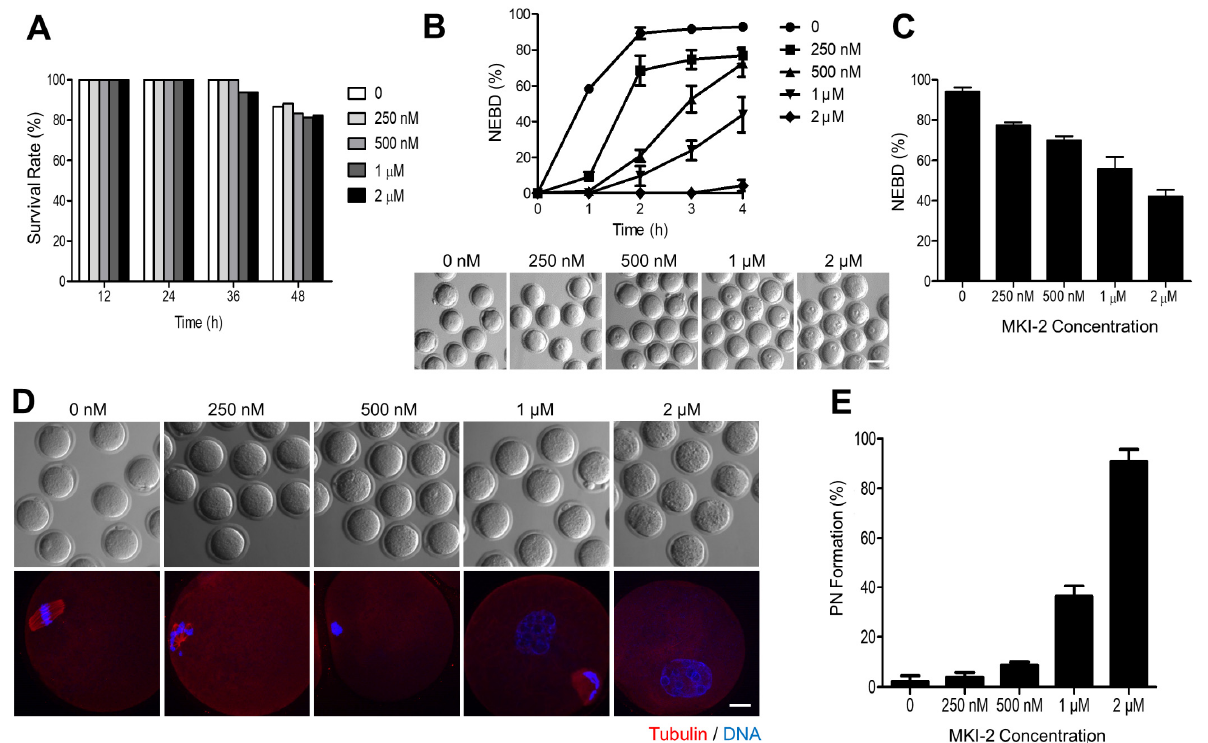
Figure 5. Validation of MKI-2 activity using mouse oocytes ( A ) GV oocytes were treated with 0, 0.25, 0.5, 1.0, and 2.0 µ M MKI-2 and scored for survival rate up to 48 h. ( B ) After 30 min of culture with MKI-2 and IBMX, GV oocytes were released from prophase arrest by washing out IBMX and were scored for GVBD. The percentage of GVBD was expressed as mean ± SEM from three independent experiments. Representative images at 4 h of culture following IBMX release were shown. Scale bar, 100 µ m. ( C ) After 18 h of culture with MKI-2 in the absence of without IBMX, the percentage of GVBD was scored and expressed as mean ± SEM from three independent experiments. ( D ) MII oocytes were collected and treated with MKI-2 in M2 medium for 8 h. Oocytes were fixed and stained with anti-tubulin antibodies. DNA was counterstained with DAPI. Scale bar, 20 µ m. ( E ) Nuclei with decondensed chromatin were evaluated. Data were expressed as mean ± standard deviation of three independent